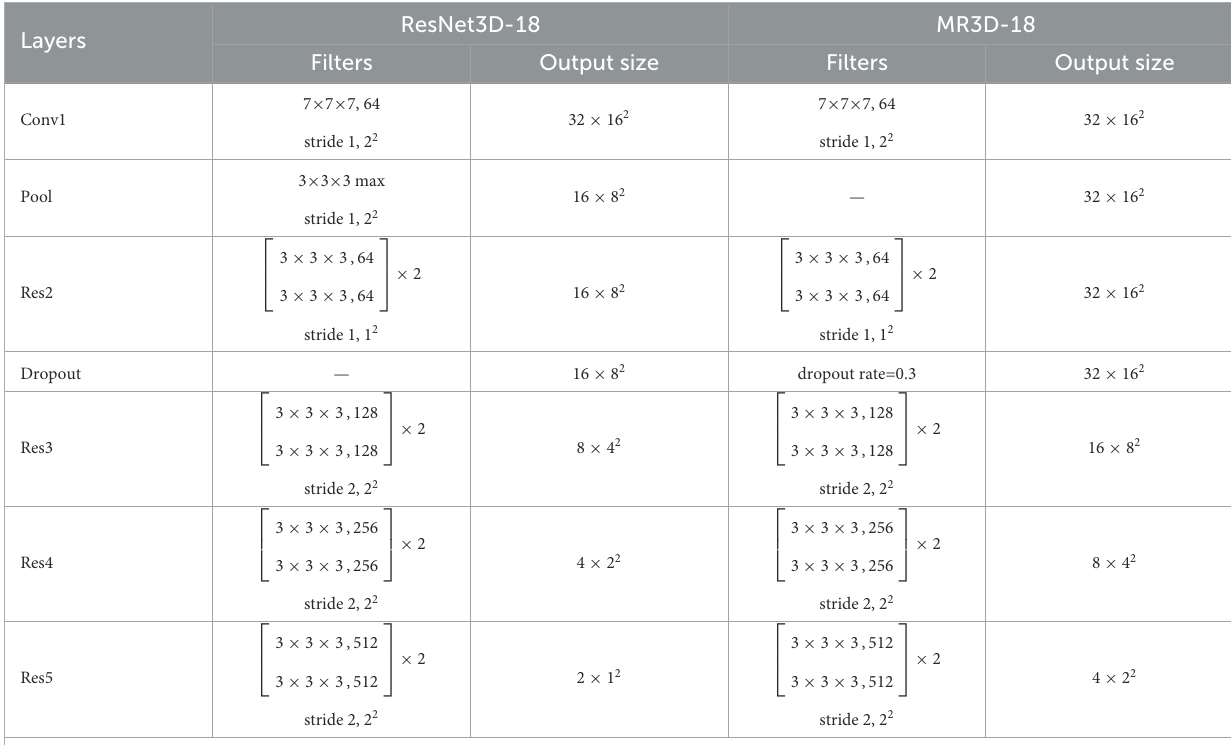
TABLE 1 Comparison between ResNet3D-18 and MR3D-18 networks with a 32 × 32 input tactile frame.